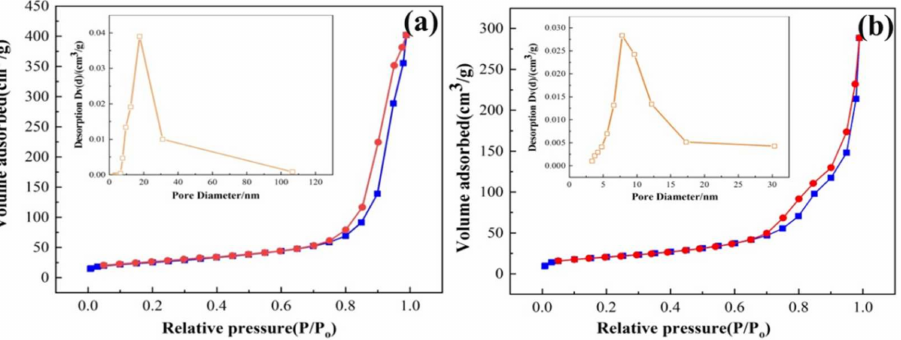
Figure 10. The N 2 adsorption-desorption isotherms and pore size distribution curves. ( a ) MgO obtained by calcination of Mg(OH) 2 ( b ) MgO obtained by calcination of 4MgCO 3 · Mg(OH) 2 · 4H 2